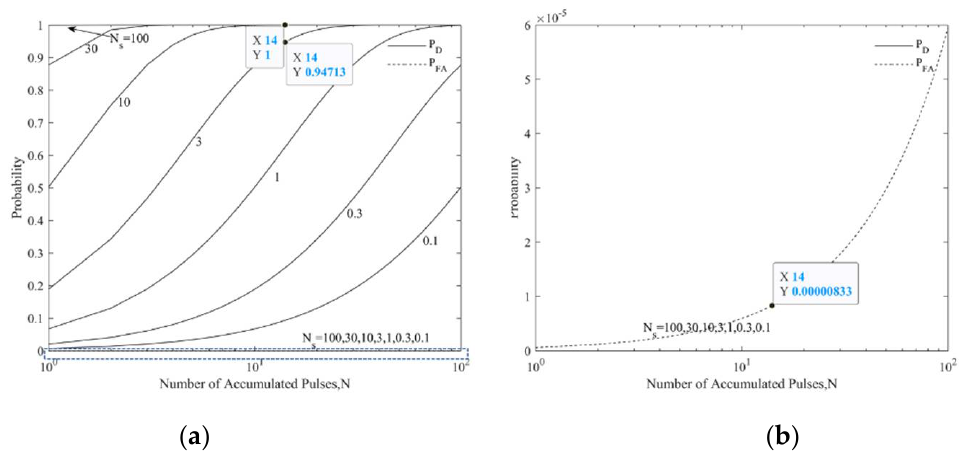
= 100, 30, 10, 3, 1, 0.3, 0.1, (cid:1866) = 8.5 × (cid:3046) (cid:3041)